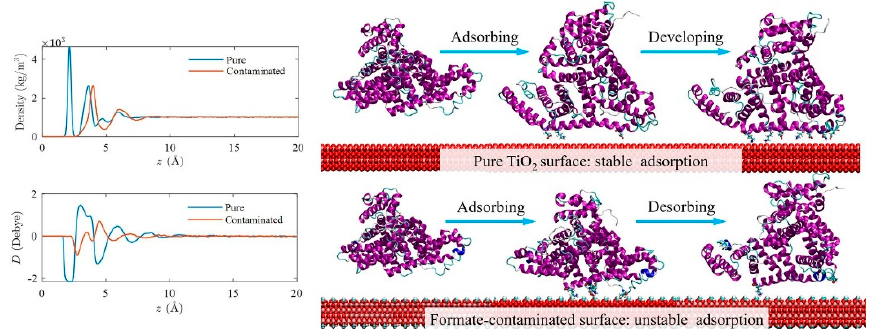
Figure 12. The density and dipole moment distributions of water molecules near the pure and formate contaminated surfaces; the scheme of the adsorption of BSA on pure TiO 2 and formate contaminated TiO 2 surface. Reprinted from Ref. [132] with permission from Elsevier.